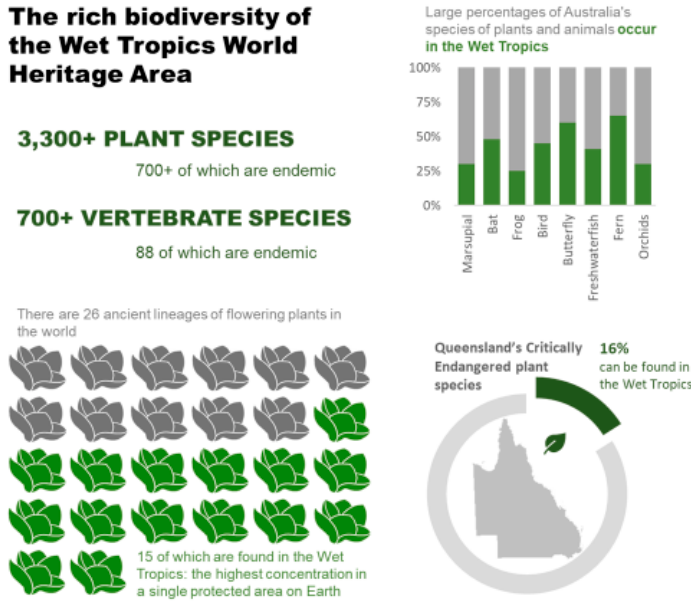
Figure 2. The rich biodiversity of the Wet Tropics World Heritage Area.